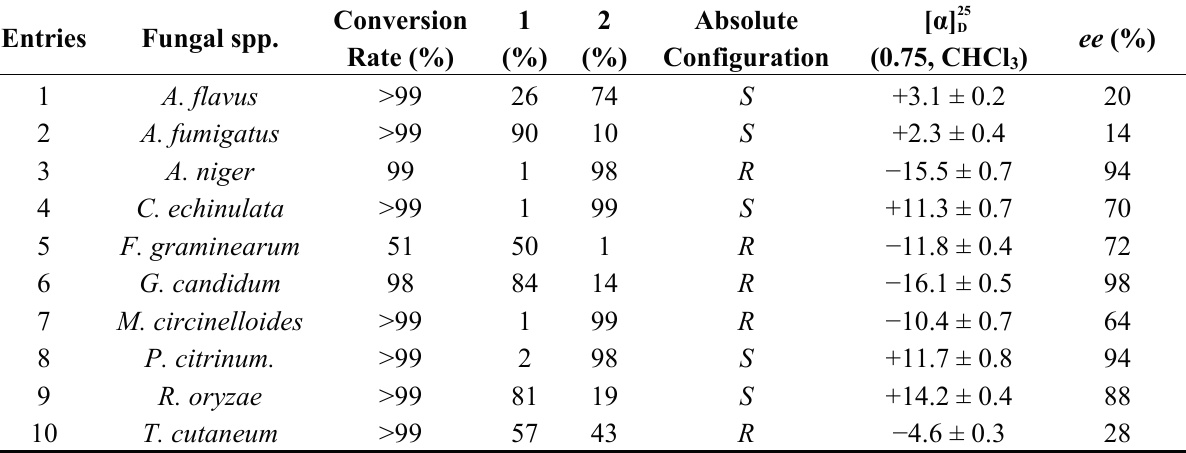
Table 1. Biotransformation of dehydrozingerone 3 . Products distribution (in %) of zingerone 1 and chiral zingerol 2 after fed with 3 at 0.5 mg/mL with filamentous fungi. Absolute configuration, optical rotations ( α ) and enantiomeric excess of 2 are